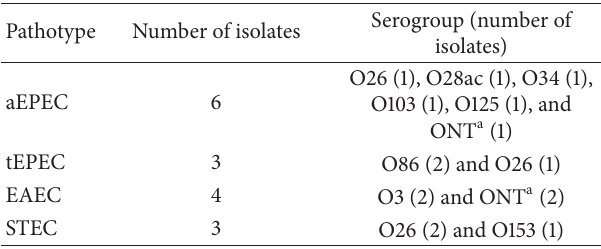
Table 2: DEPs strains isolated from children with acute diarrhea from households with high socioeconomic